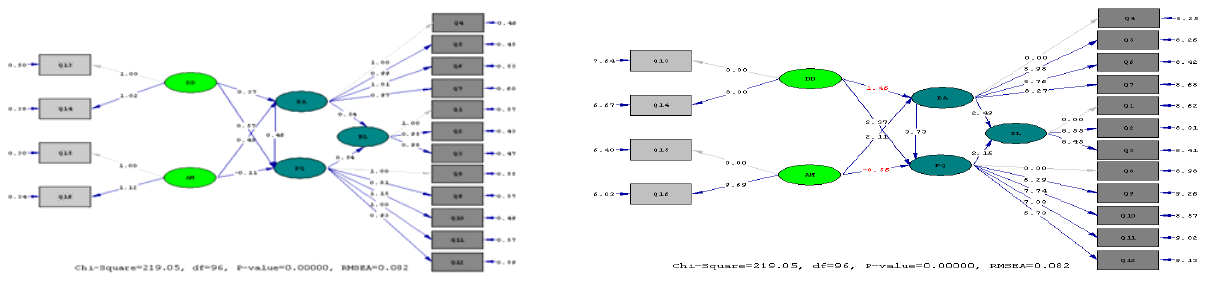
Fig. 2. The results of standard values Fig. 3. The results of t-student